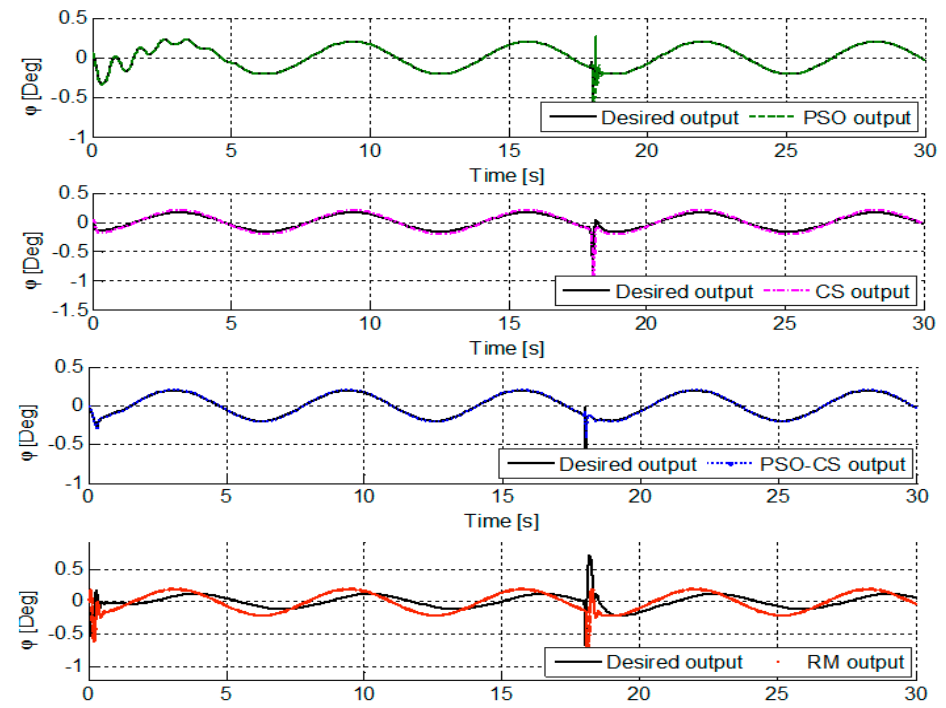
Figure 16. Quadrotor’s roll attitude ( ϕ ) using Particle Swarm Optimization (PSO), Cuckoo Search (CS), Particle Swarm Optimization-Cuckoo Search (PSO-CS), and Reference Model (RM) (helical trajectory).